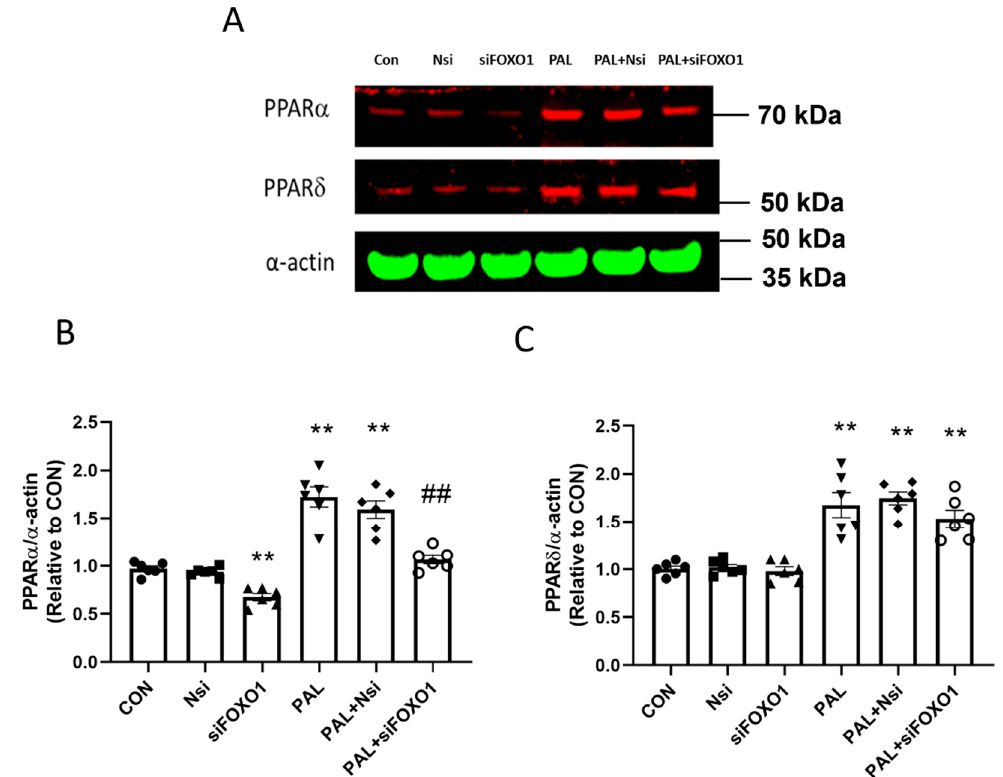
Figure 8. PPAR α ( A , B ) and PPAR δ ( A , C ) protein expression in C2C12 myotubes after FOXO1 siRNA gene silencing in the absence ( left panels ) or the presence of palmitate (PAL; right panels ). Significantly different from control without PAL (CON, ** p < 0.01). Significantly different from CON + PAL ( ## p < 0.01). Data represent mean ± SEM of 6 individual experiments for each intervention group. Nsi—silencer negative control.